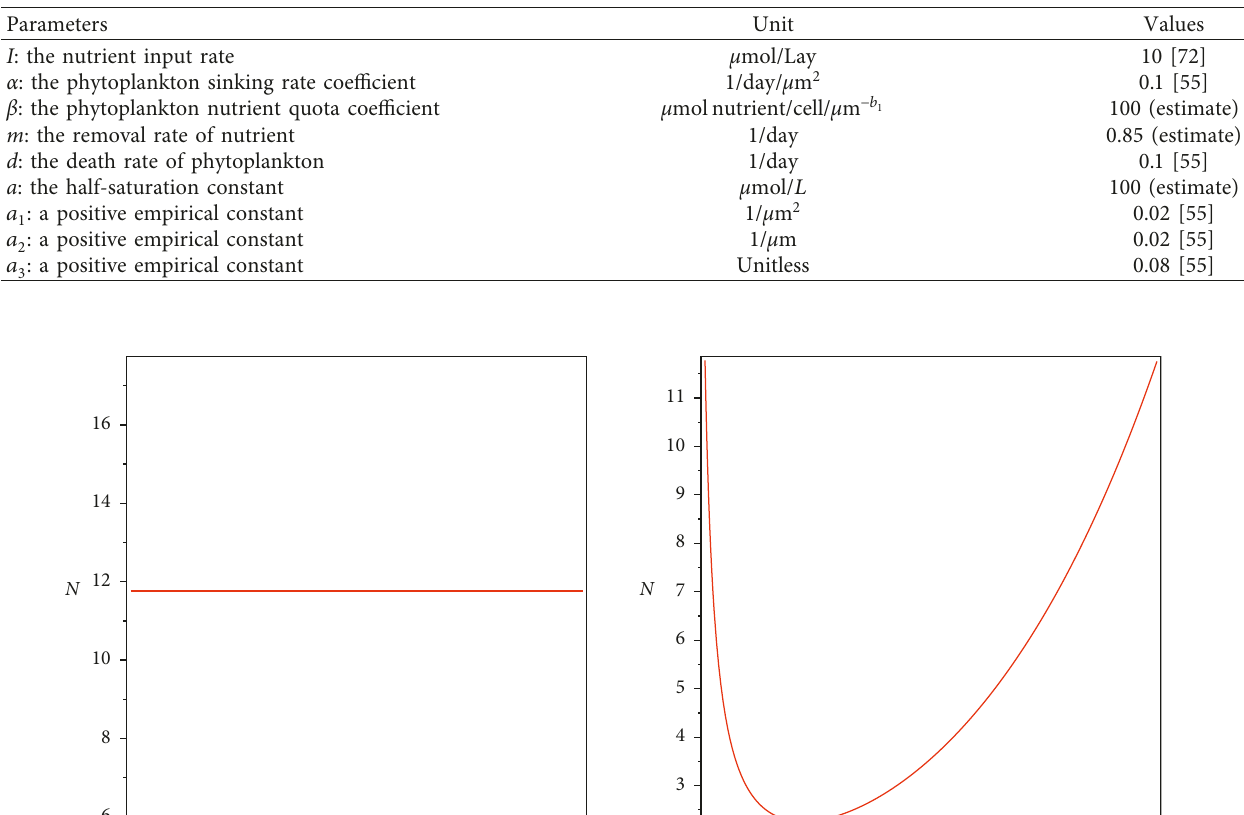
Table 1: Parameter values in numerical simulations for model (1) and model